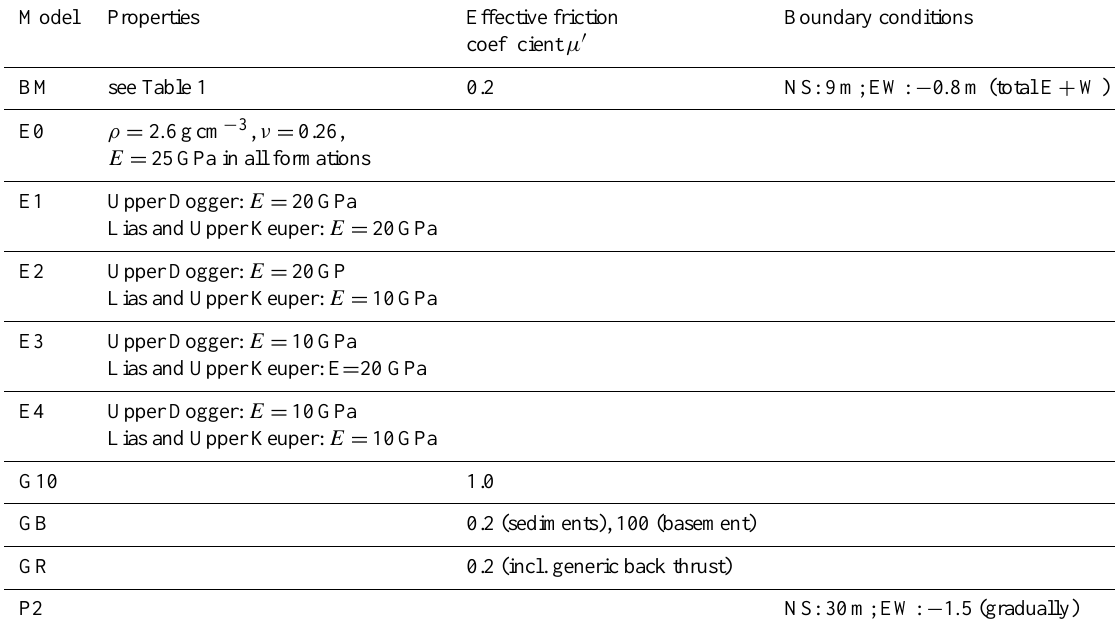
Table 2. Properties of the model variants (only changes with respect to the base model BM are listed). Model Properties Effective